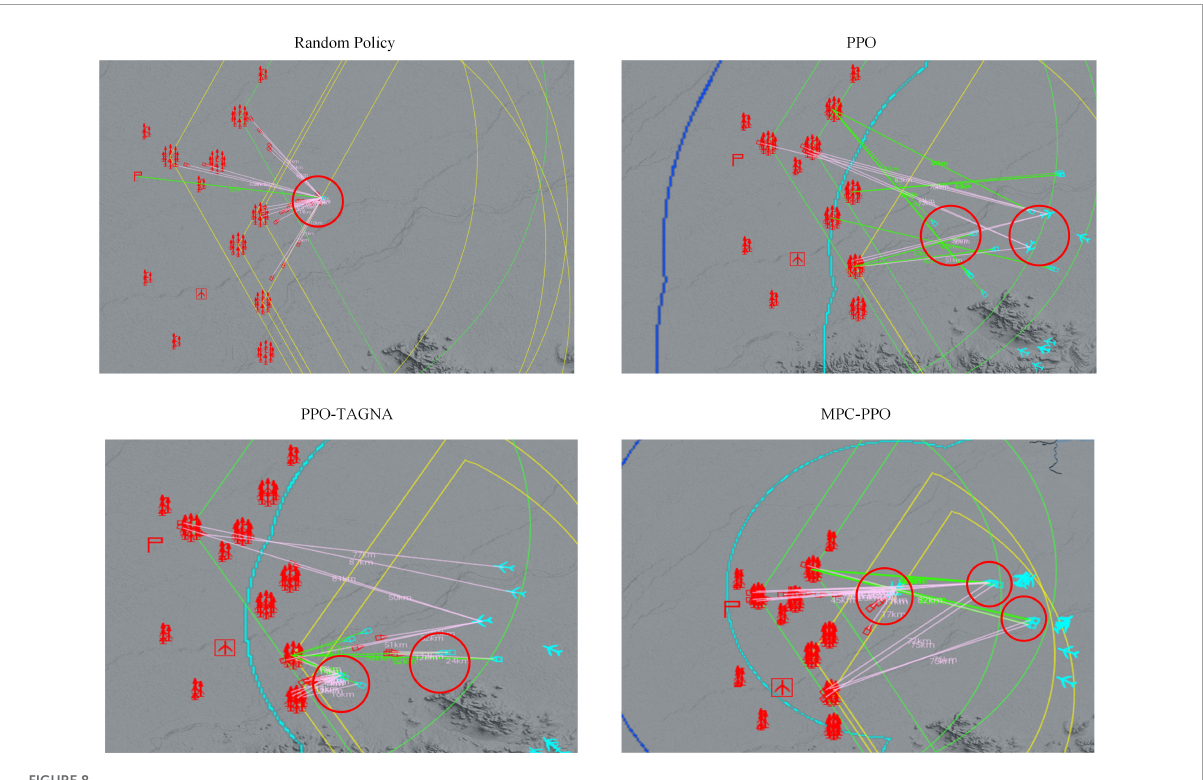
FIGURE8 Comparison of behavioral